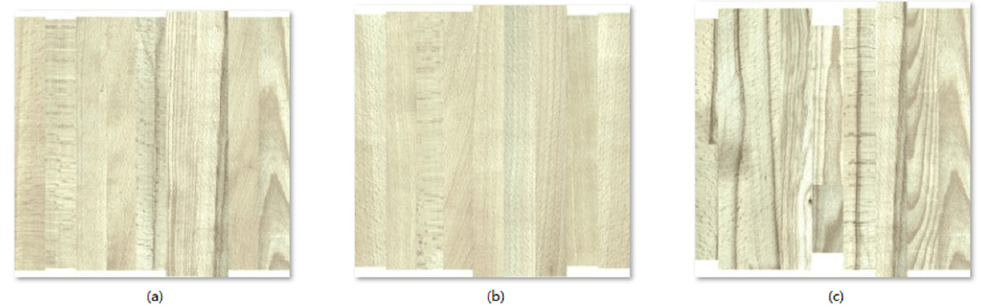
Figure 11. Second-order color moment result images: ( a ) the first clustering result images, ( b ) the second clustering result images with smooth outer surface, ( c ) the second clustering result images with obvious texture information.